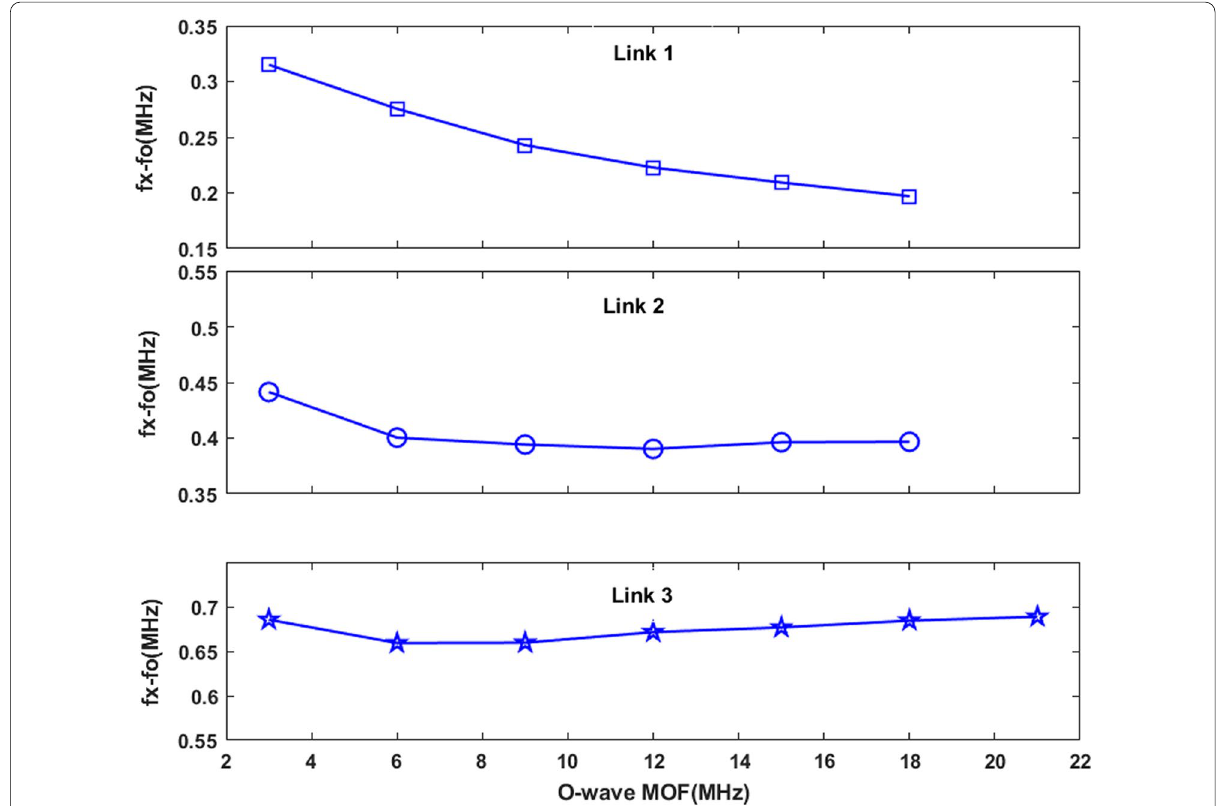
Fig. 8 Correlation between the separation and the O-wave